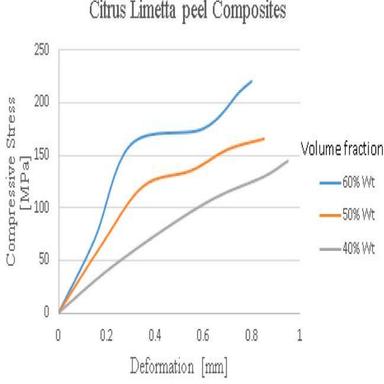
The effect of compression stress on volume fraction for Citrus limetta peel powder composites.